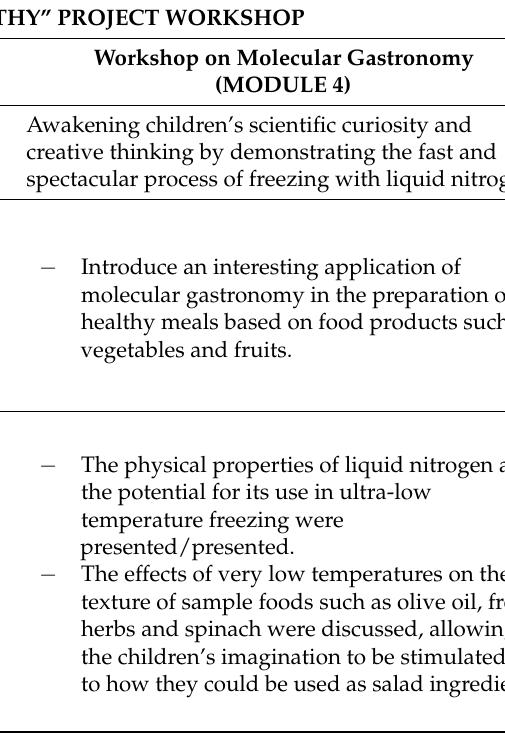
Table 2. Discussion of how week 2 of the “Colourful means healthy” project workshop was